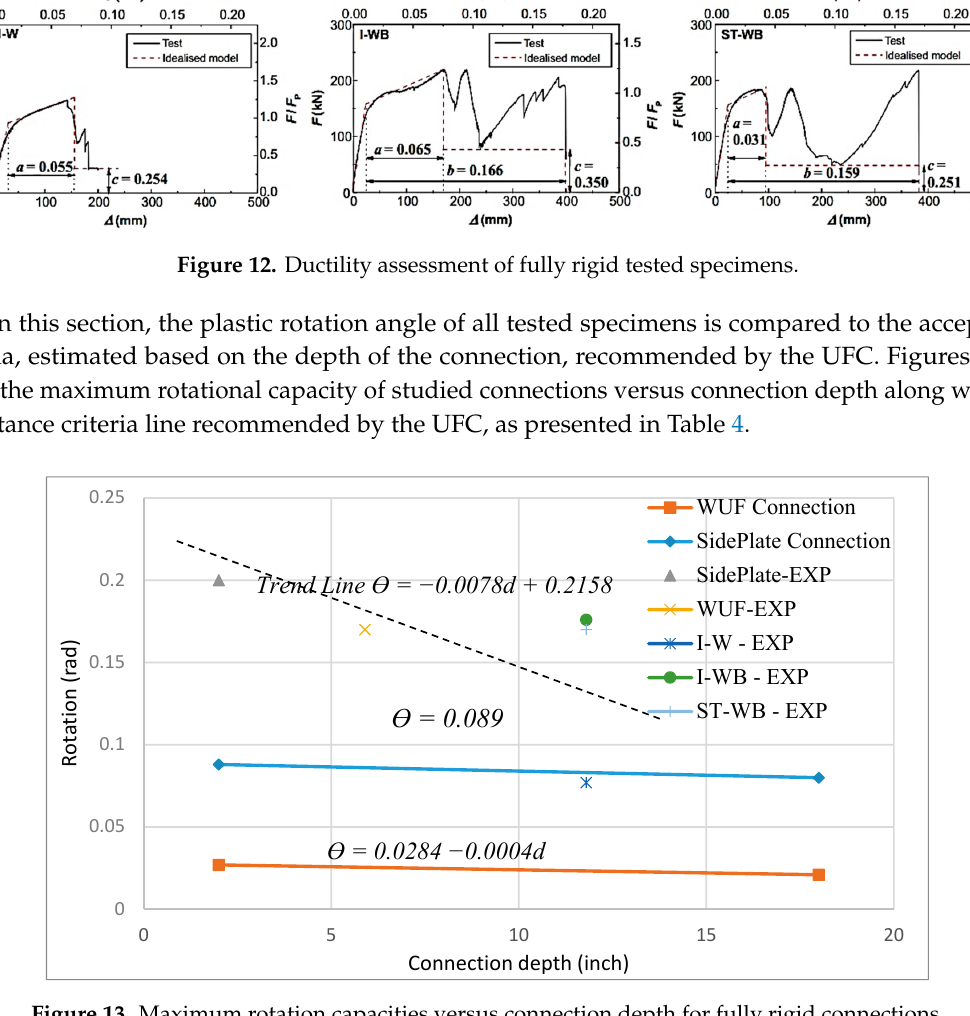
Figure 13. Maximum rotation capacities versus connection depth for fully rigid connections.